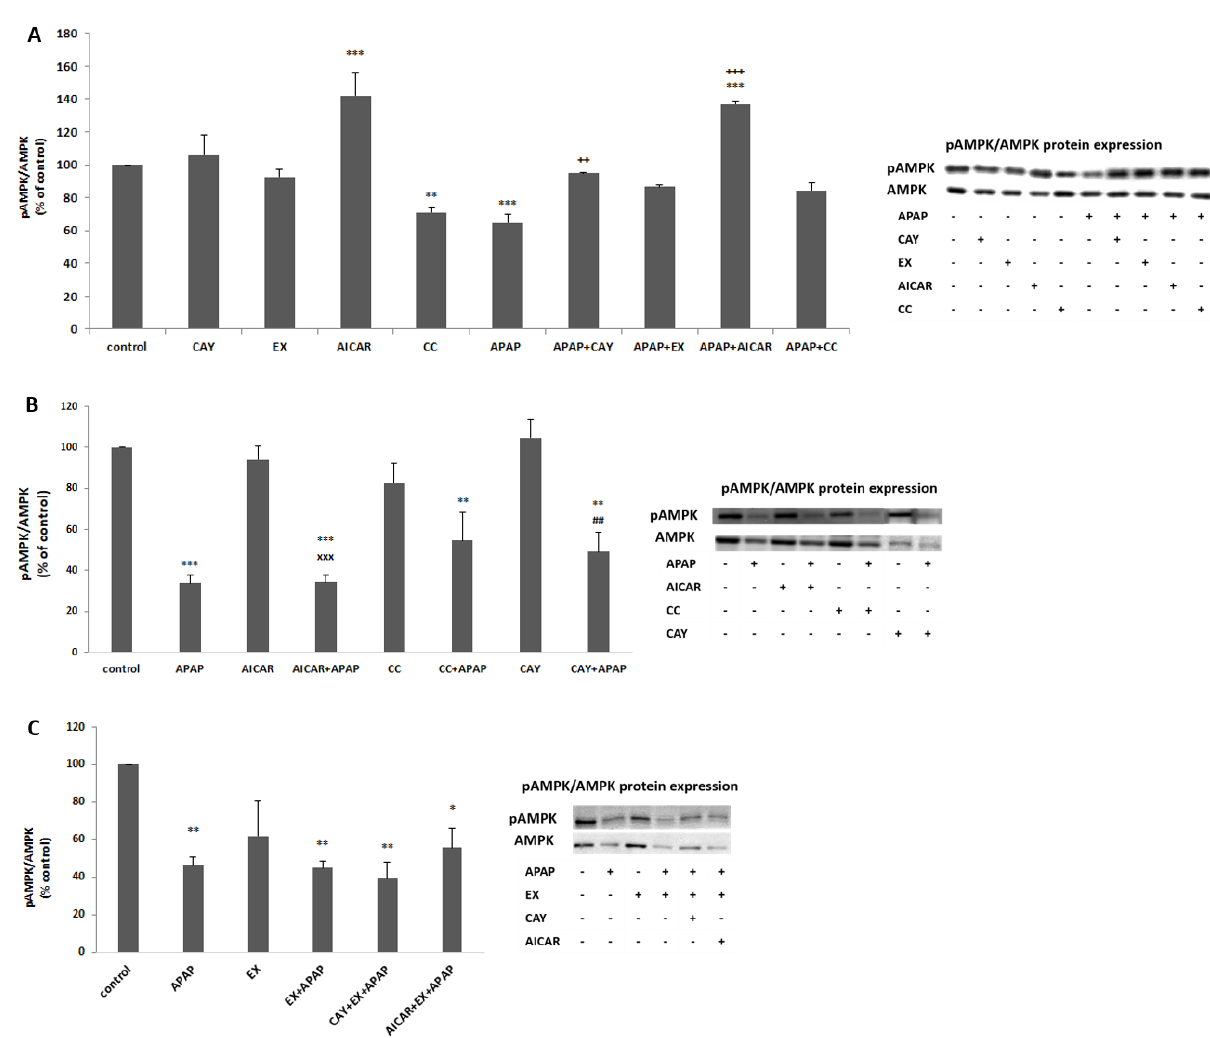
Fig. 3. Effects of acetaminophen (APAP), specific modulators of AMPK (activator – AICAR and inhibitor – Compound C, CC) and SIRT1 (activator – CAY10591/CAY and inhibitor EX-527/EX) on AMPK activity in cultured primary rat hepatocytes after A. 4 h, B,C. 24 h. Activity of AMPK was calculated as pAMPK/AMPK ratio of protein expression. Quantitative data of optical band densitometry (graphs) and representative Western blot images are presented. Data are expressed as means ± SEM (n=3–5): * P <0.05; ** P <0.01; *** P < 0.001 vs. respective control; + P <0.05; ++ P <0.01; +++ P <0.001 APAP in combination vs. APAP alone; XXX P <0.001 vs. AICAR; ## P <0.01 vs.